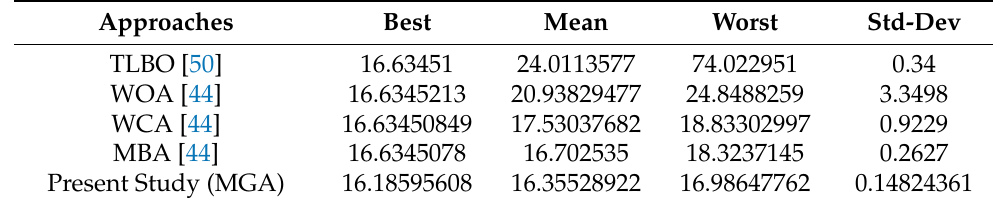
Table 15. Statistical results of different approaches for the step-cone pulley design